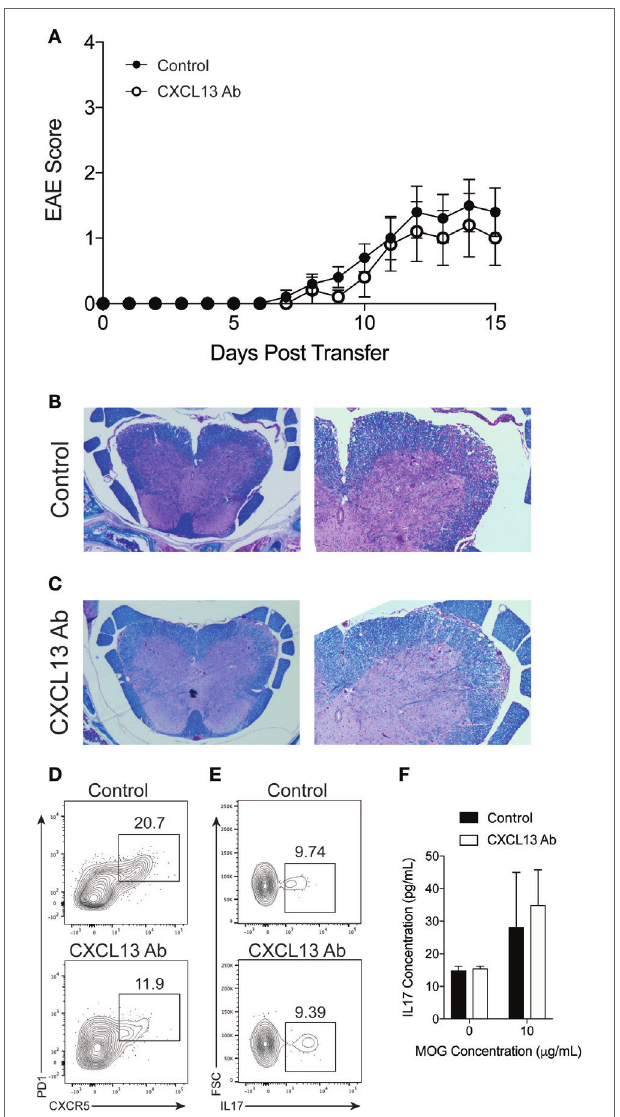
FigUre 7 | CXCL13 antibody treatment is not effective protection against TH17-experimental autoimmune encephalomyelitis (EAE) in B cell-deficient mice. TH17-EAE was induced in μ MT mice and treated with either anti-CXCL13 or an isotype control twice a week beginning at Day 0 post-transfer of TH17 cells. (a) Disease score was monitored. Data were compiled from three experiments and statistical significance at each day was determined using a Mann–Whitney test ( N = 10 total mice per treatment group). Histological analysis of representative spinal cord sections stained with H&E and Luxol Fast Blue in mice treated with (B) control antibody or (c) anti-CXCL13. Representative FACS plots of the percentage of spinal cord-infiltrating (D) CXCR5 + PD1 + TFH cell (in the CD4 + cell gate), and (e) IL-17 + cells (in the CD4 + CD44 + cell gate) of mice treated with anti- CXCL13 or isotype control. (F) MOG-specific IL-17 responses in the spleen were assessed through ELISA ( N = 3 mice per